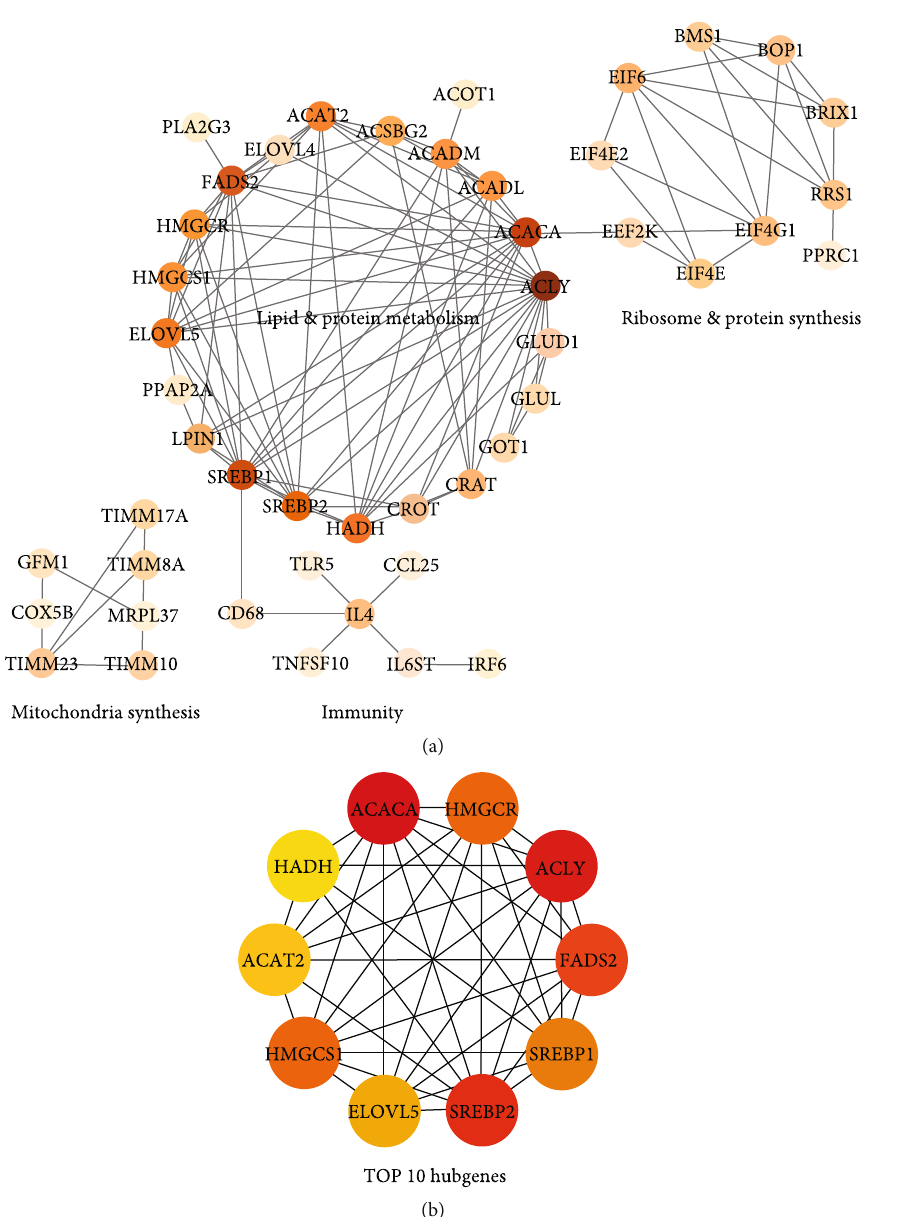
Figure 3: Potential association network for DEGs predicted by Cytoscape software with high con fi dence. (a) DEGs were clustered into 4 categories, namely, lipid and protein metabolism, mitochondria synthesis, immunity, and ribosome and protein synthesis. (b) Top 10 hub genes calculated by the cytoHubba